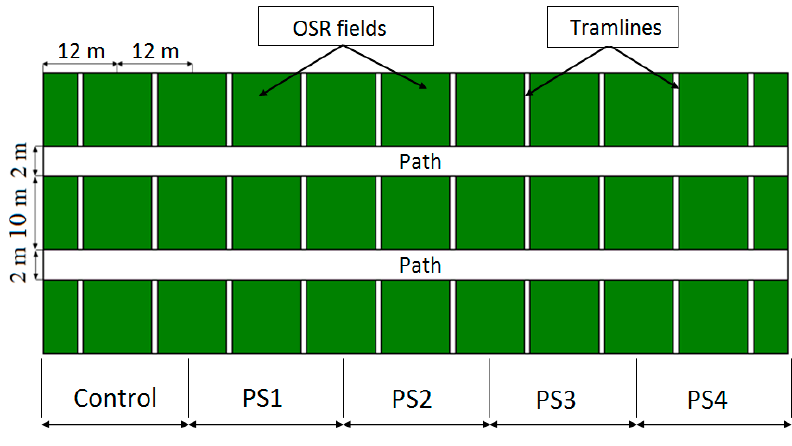
Figure 1. Research field trial scheme.